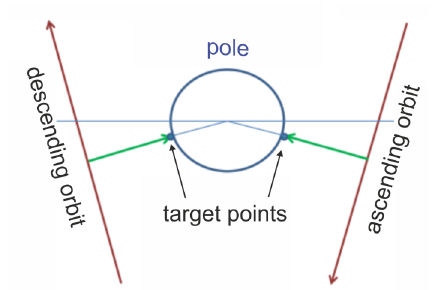
Figure 1. Outline of SAR reflection points at a pole. The reflection point depend on the SAR satellite orbit like ascending or descending of the TerraSAR-X.